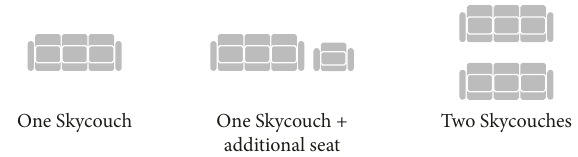
Figure 1: Air New Zealand’s Economy Skycouch